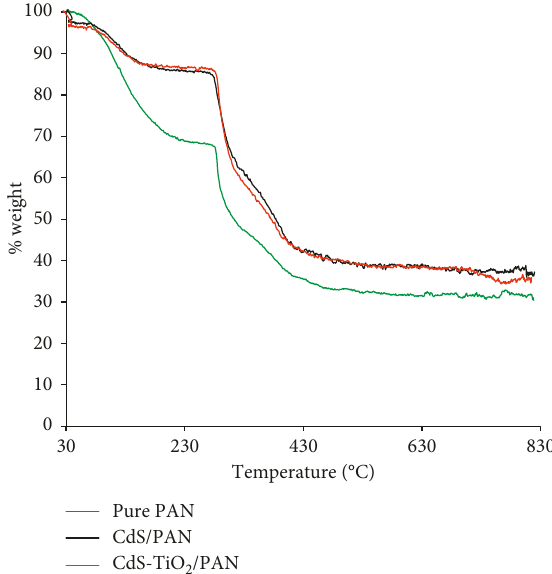
Figure 6: TGA thermograms of pure PAN, CdS-TiO